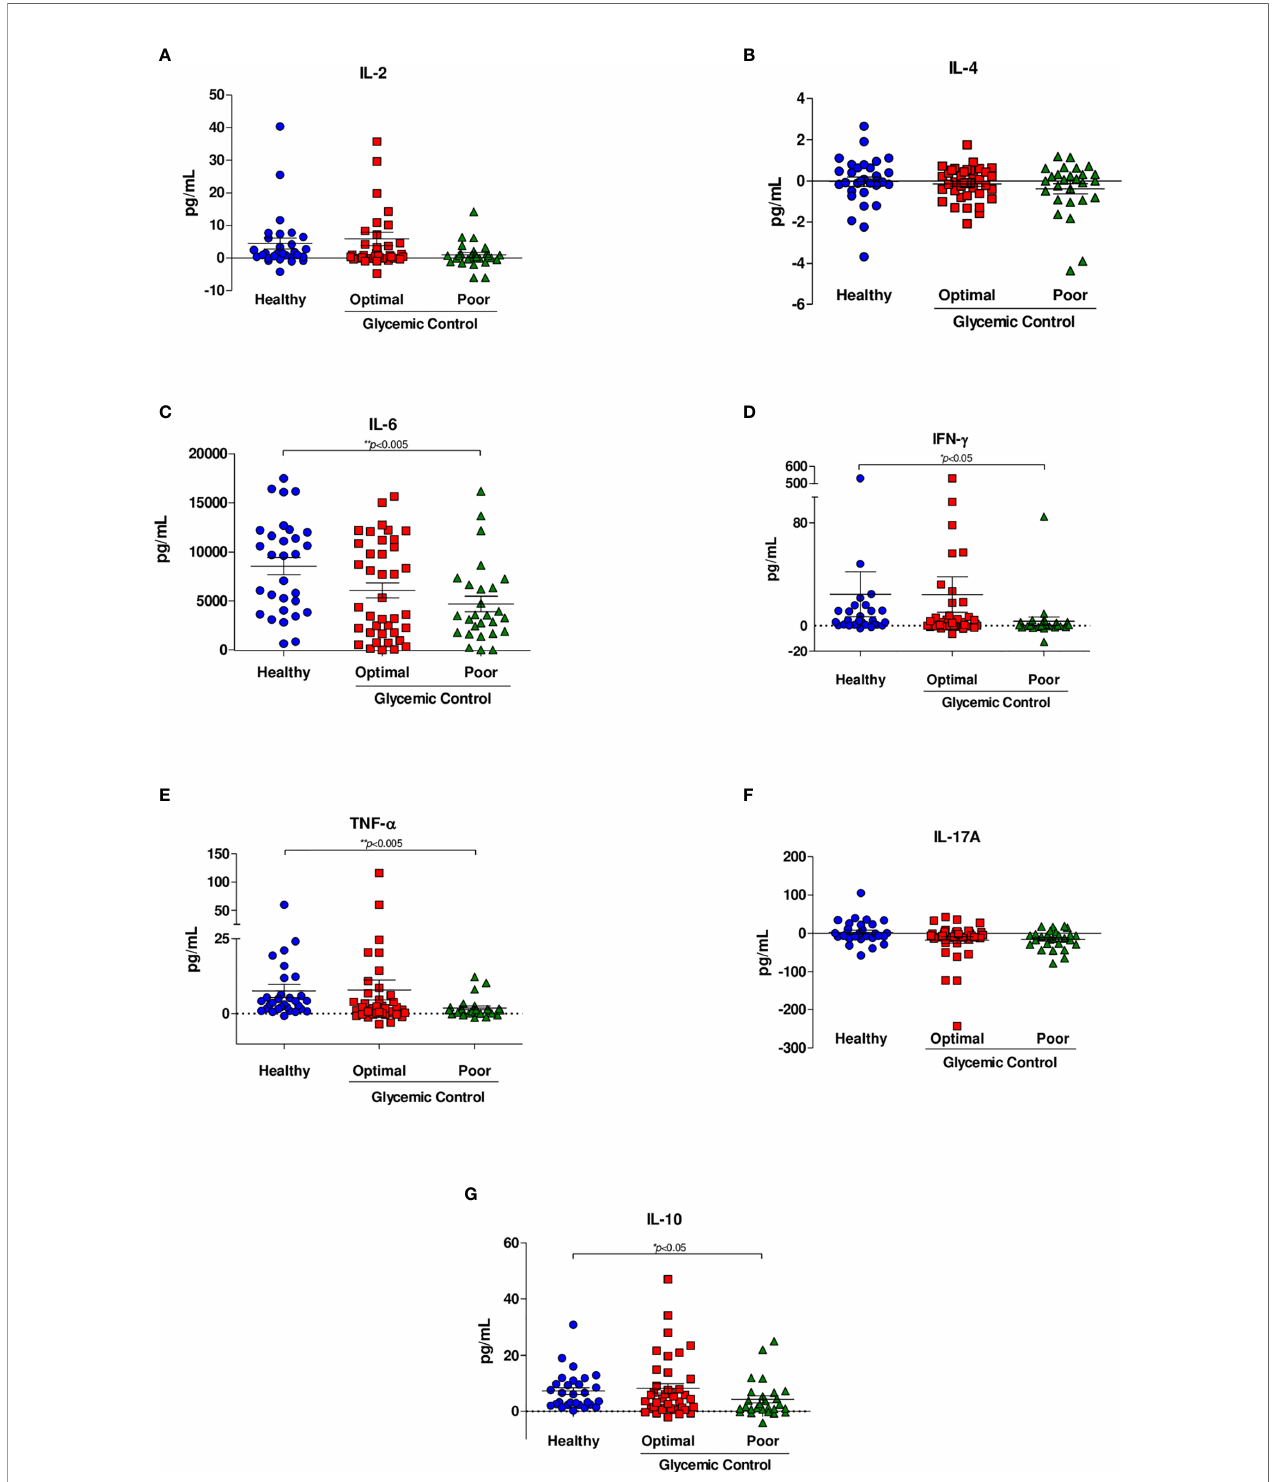
FIGURE 2 | Cytokine secretion in response to M. tuberculosis H37Rv. Cytokine levels were assessed by CBA analyses of supernatants from whole blood inhibition assays of healthy subjects (n=44), patients with optimal glycemic control (HbA1c<7) (n=54) and patients with poor glycemic control (HbA1c>8) (n=35). (A) IL-2, (B) IL-4, (C) IL-6, (D) IFN- g , (E) TNF- a , (F) IL-17A, (G) IL-10. Data are presented as scatter plots, with each symbol representing a single individual. The data were analyzed using one-way ANOVA with a post hoc test. p <0.05 was regarded as signi fi cantly